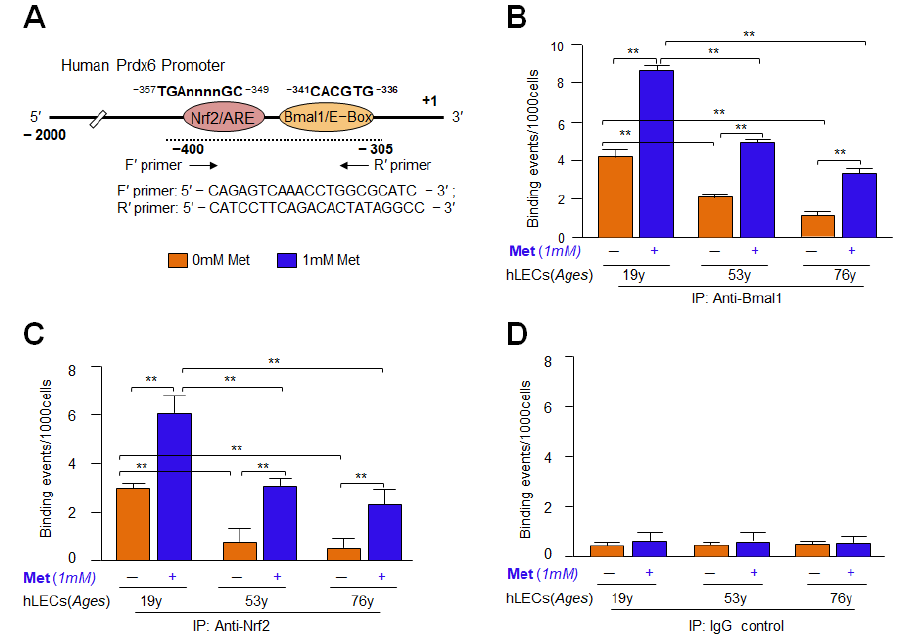
Figure 12. Aging hLECs displayed a significant loss in Bmal1/E-Box or Nrf2/ARE binding and was revived by Metformin. ( A ) Schematic illustration of Prdx6 gene promoter containing Bmal1/E-Box and Nrf2/ARE sites with sequences and position as well as primer location and sequences. ( B – D ) In vivo DNA-binding assay, ChIP assay revealed that Metformin revived binding activity of Bmal1 and Nrf2 to their corresponding sites in the Prdx6 promoter in aging hLECs. ChIP was conducted with antibodies specific to Bmal1 ( B ), Nrf2 ( C ), and nonspecific IgG control ( D ). Immunoprecipitated DNA fragments isolated from different ages of primary hLECs were purified and processed for RT-qPCR analyses using primers shown in Figure. Histograms represent loss of Bmal1 enrichment ( B ; orange bars) at E-Box and Nrf2 ( C ; orange bars) at ARE site, and the sites which was restored by Metformin ( B and C ; orange vs. blue bars) treatment as shown. ChIP with IgG control ( D ) antibody was used as negative control. The data represent the mean ± S.D. from three independent experiments. Vehicle control (orange bars) vs. Metformin-treated (blue bars) and young (19 y) vs. aged (53 y and 76 y) subjects; ** p < 0.001.